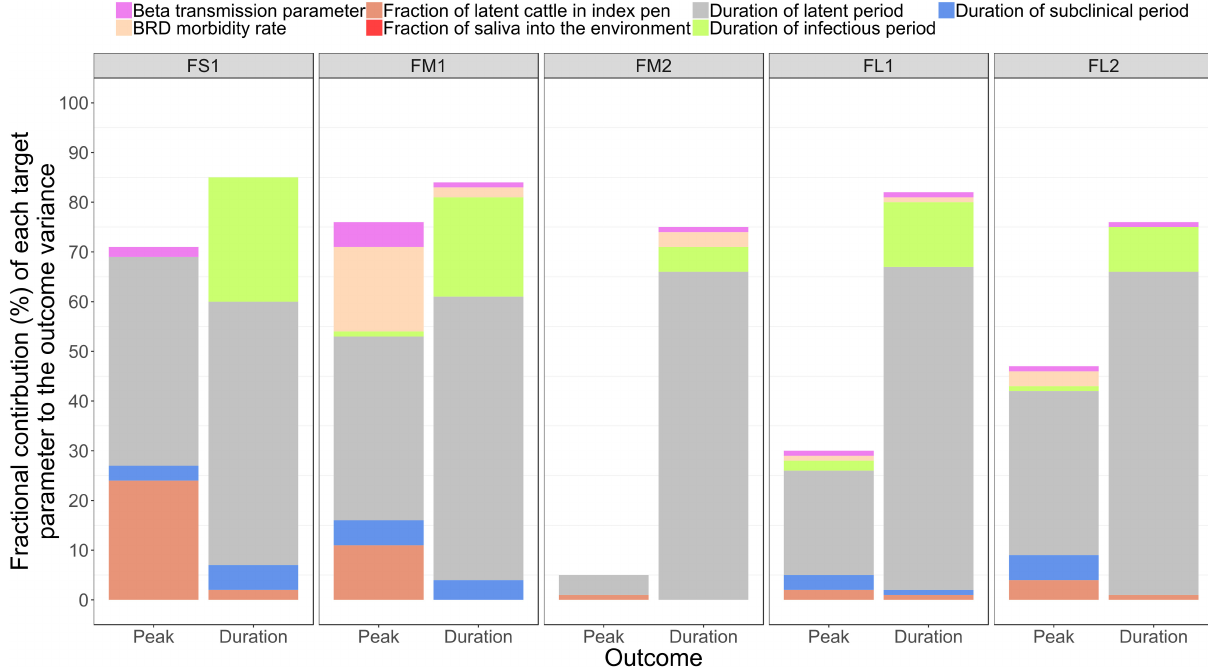
FIGURE 5 | The fractional contributions of select target parameters to the variance in each the outbreak peak day with highest number of clinical cattle and the total outbreak duration in the feedlot since the foot-and-mouth disease introduction, estimated based on n = 2,000 simulated outbreaks in each of the feedlot size and layout cases modeled. Multivariable linear regression models were developed for each of the outcome variables of the projected outbreak peak day and outbreak duration and the target parameters as the predictor variables. For each outcome, the final regression model adjusted R 2 statistic was partitioned to obtain the fractional contributions of the target parameters to the projected outcome variance. Outcomes: Peak—outbreak peak day, Duration—duration of the outbreak. Target parameters: beta transmission parameter for FMD virus transmission via direct cattle contact [Beta transmission parameter]; morbidity rate of bovine respiratory disease (BRD) during the first 30 days since cattle placement in the feedlot [BRD morbidity rate]; initial proportion of FMD latent cattle in the index home-pen [Proportion of latent cattle in index pen]; fraction of the daily saliva volume produced by an animal that is deposited into the home-pen environment [Fraction of